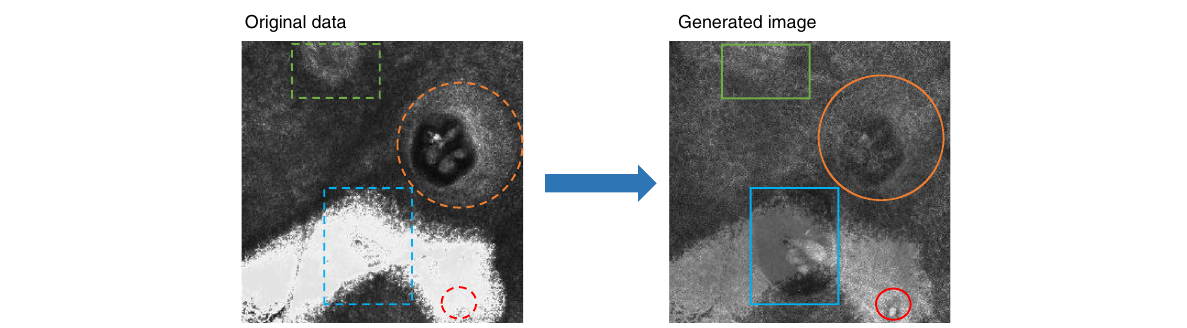
Fig. 5 Generation of the original images with demodicosis based on small sample. This shows the generation effect of the picture containing the demodicosis. The generated data has data that is very similar to the original data, as well as different data